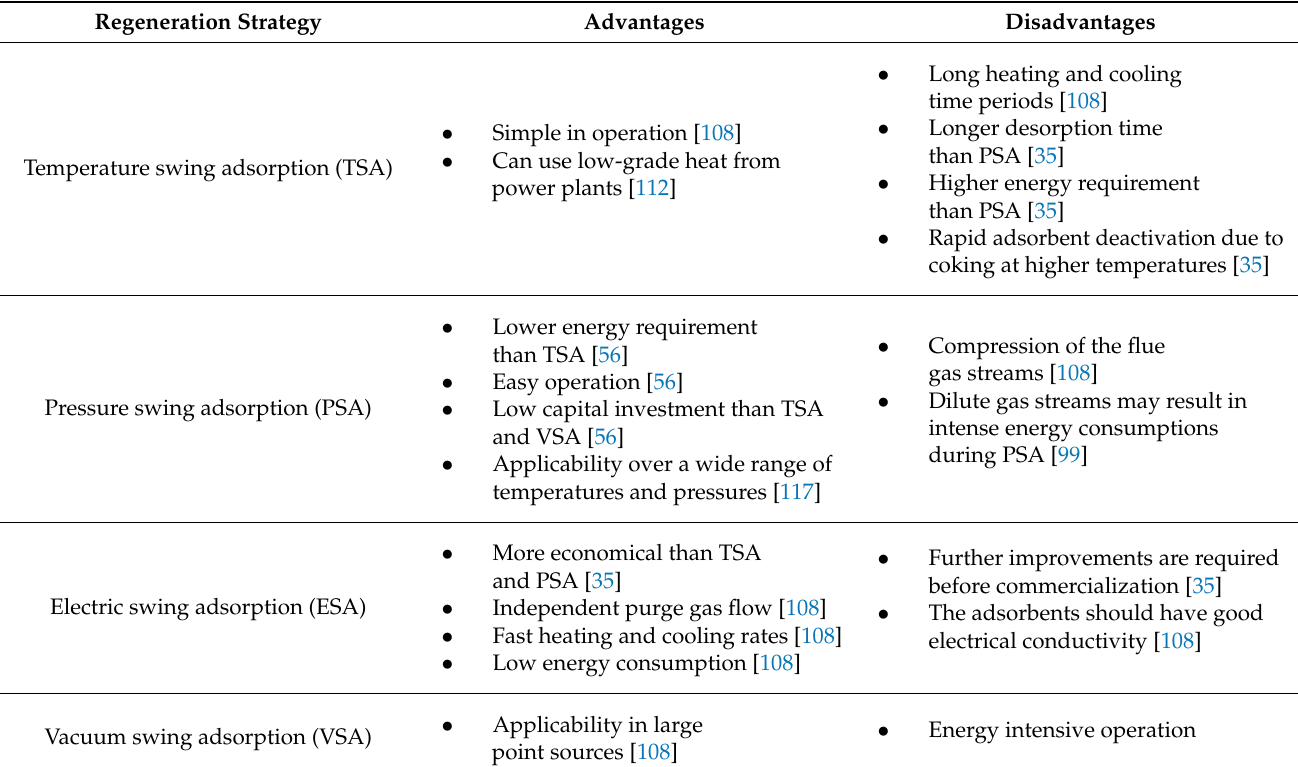
Table 5. Comparison of different regeneration